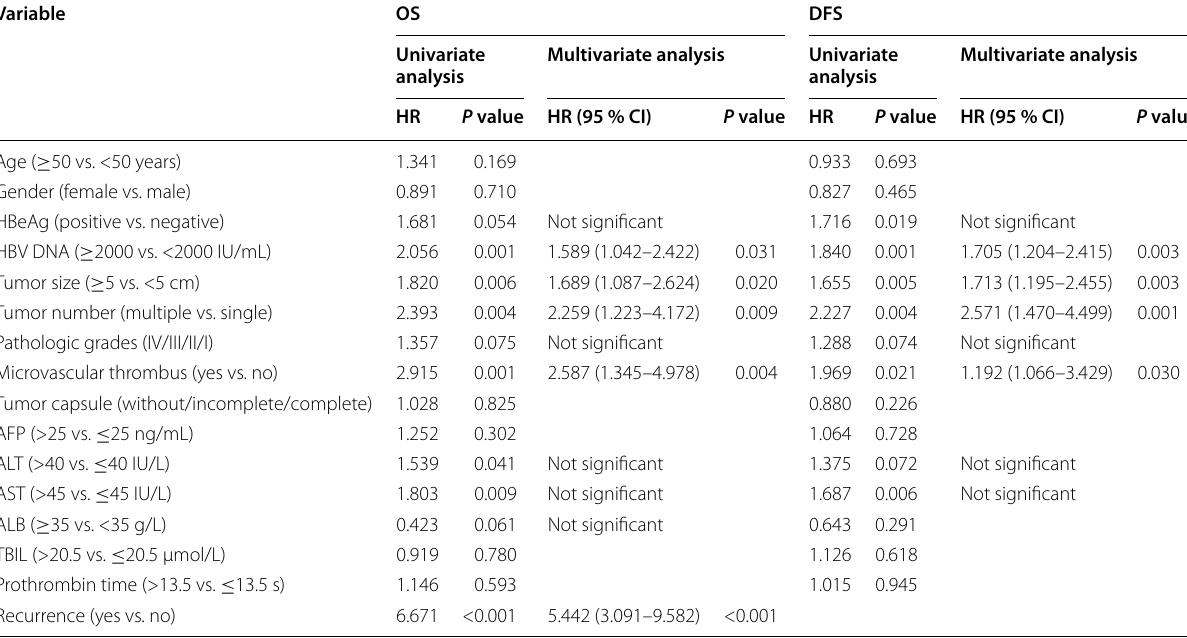
Table 4 Relationship between clinical characteristics and OS/DFS in patients without antiviral treatment ( n as determined by univariate and multivariate Cox regression analysis